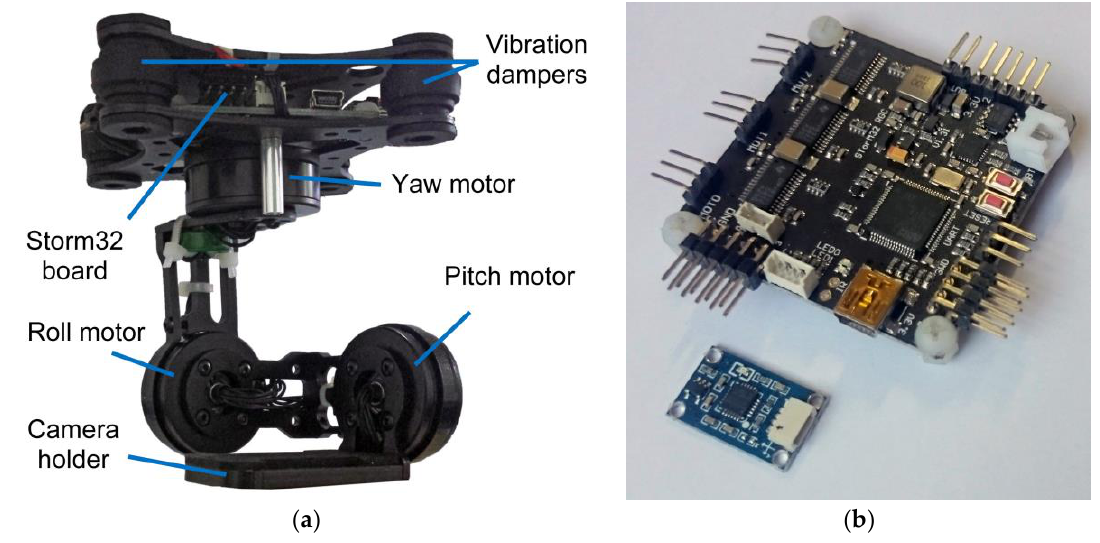
Figure 5. ( a ) Used gimbal; ( b ) gimbal controller (Storm32) board and primary Inertial Measurement Unit (IMU) (MPU6050).